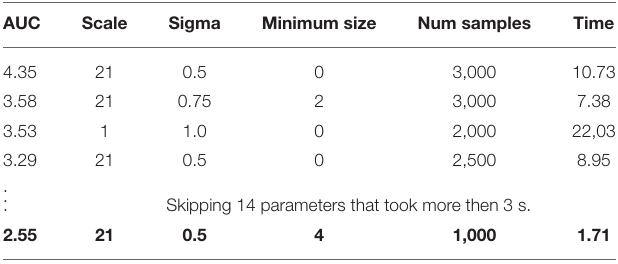
TABLE 5 | Best parameters for LIME with Felzenszwalb segmentation.